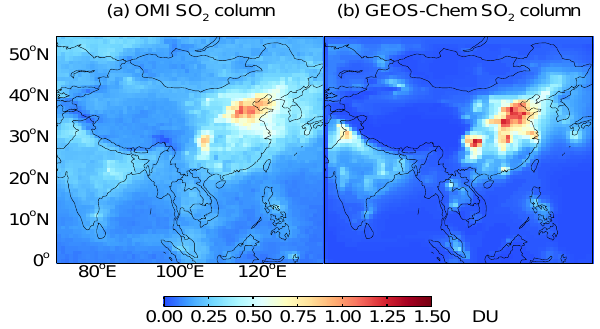
Figure 4. Annual mean total SO 2 columns from (a) the OMI satel- lite instrument and (b) GEOS-Chem simulation for the year